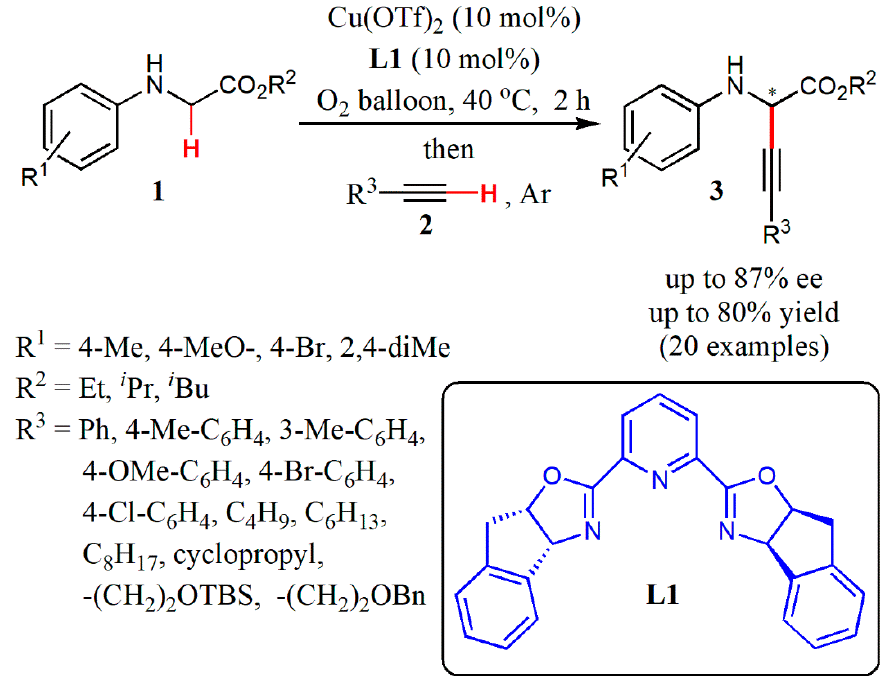
Figure 2. Enantioselective CDC of N -aryl glycine esters with terminal alkynes.